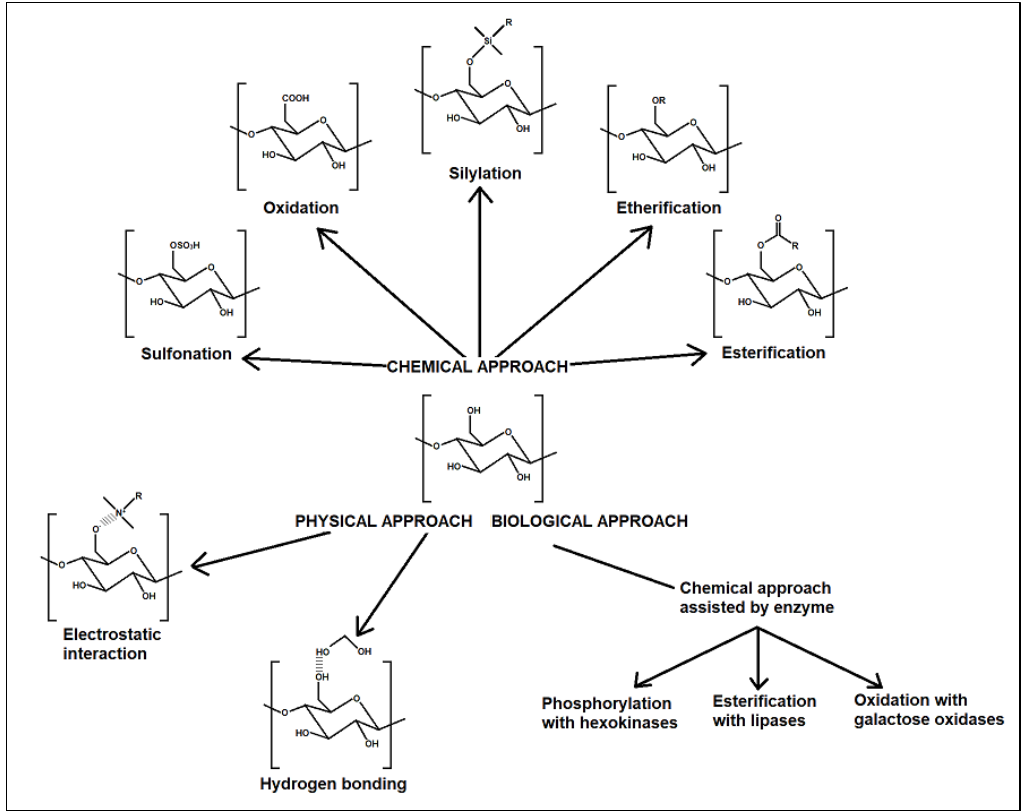
Figure 3. Several surface modification reactions of nanocellulose via the physical, chemical, and biological approaches. biological